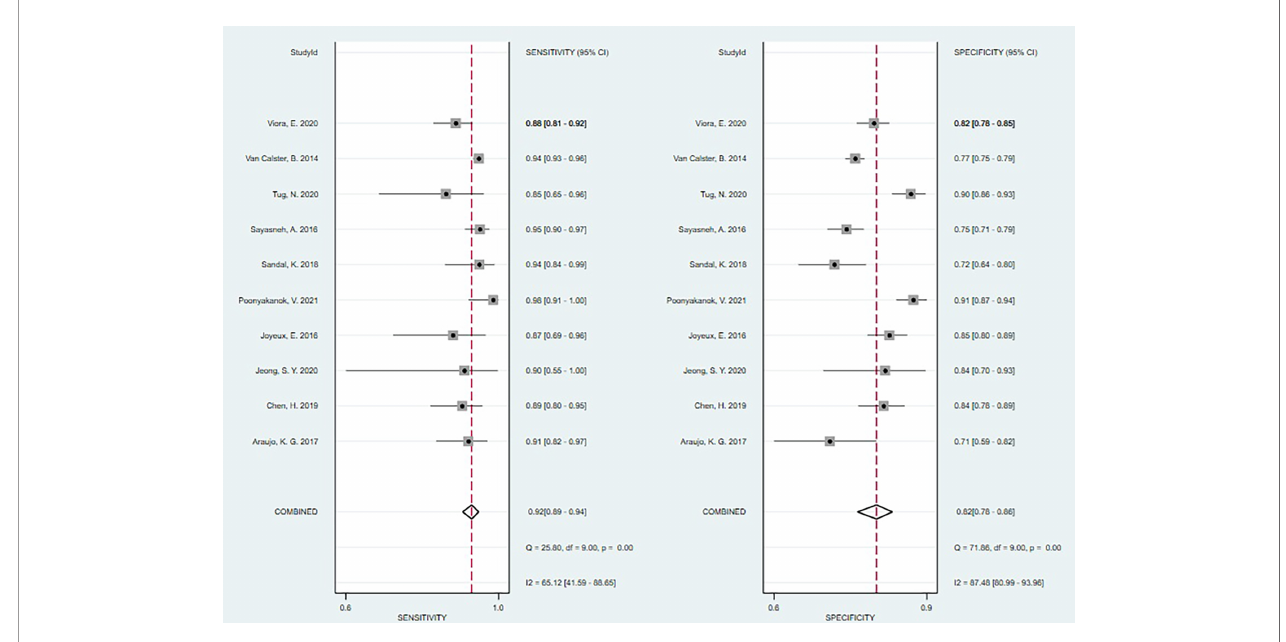
FIGURE 3 | Forest plots for the diagnostic accuracy.